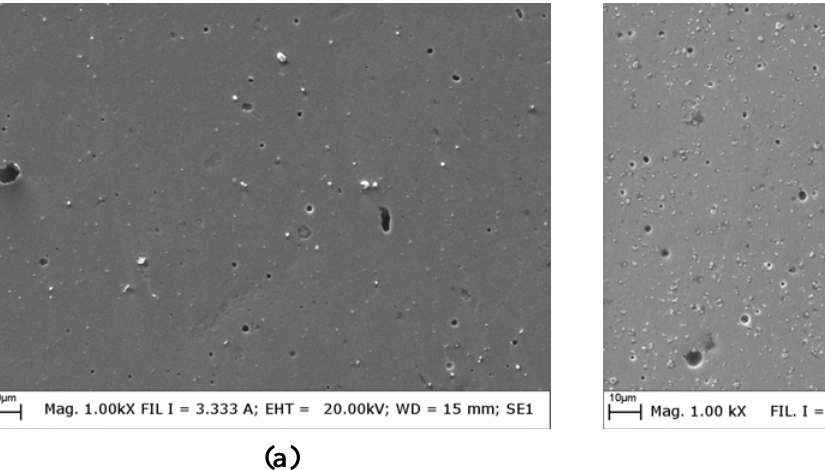
Figure 4. SEM images of ( a ) TiN and ( b ) WC/C coatings as